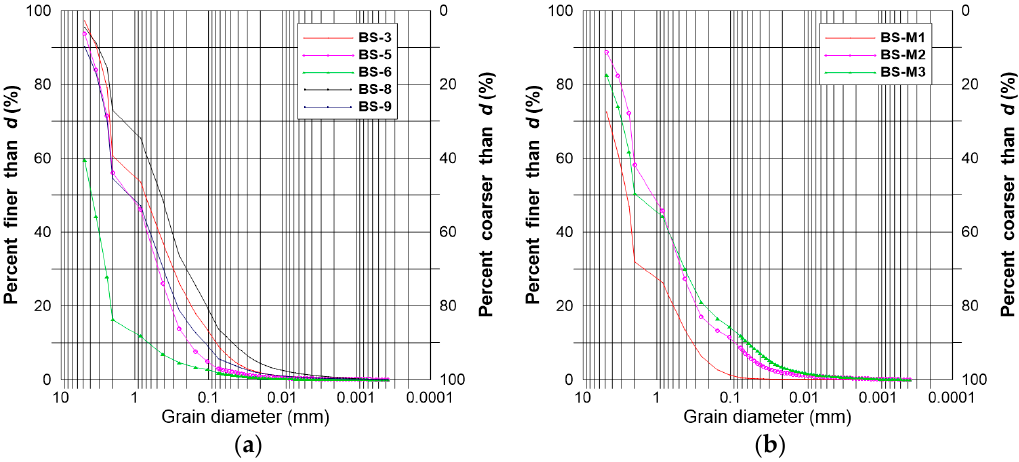
Figure 3. The results of the grain size analysis. ( a ) Five single wells and ( b ) three multi wells. Table 8. The hydraulic conductivity values based on the empirical grain size analysis (unit: m/s). Well BS-3